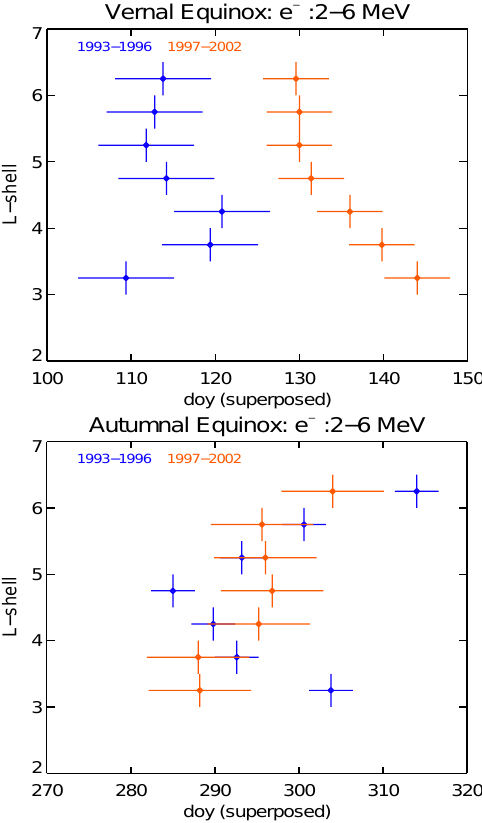
Fig. 3. (a) Superposed epoch fluxes of 27-day box car averaged 2- to 6-MeV electrons for L-values from 3.5 to 4.5 during the descending part of solar cycle 22 (1993–1996). The times of peak fluxes around the equinoctial times, their mean and standard deviations are indi- cated to the right. (b) Similar to (a) but for the ascending part of solar cycle 23 (1997–2002).